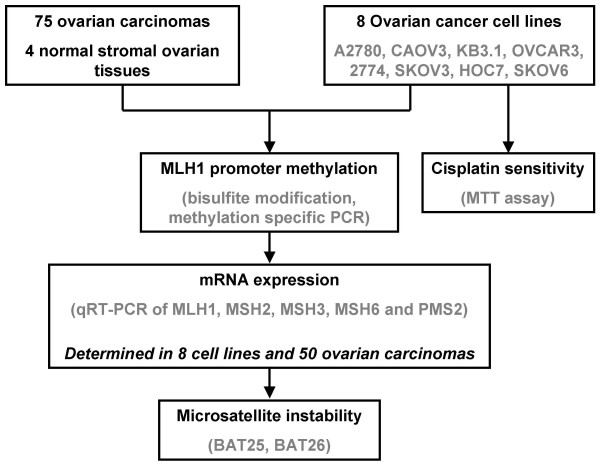
Study design. Flow chart for study design.